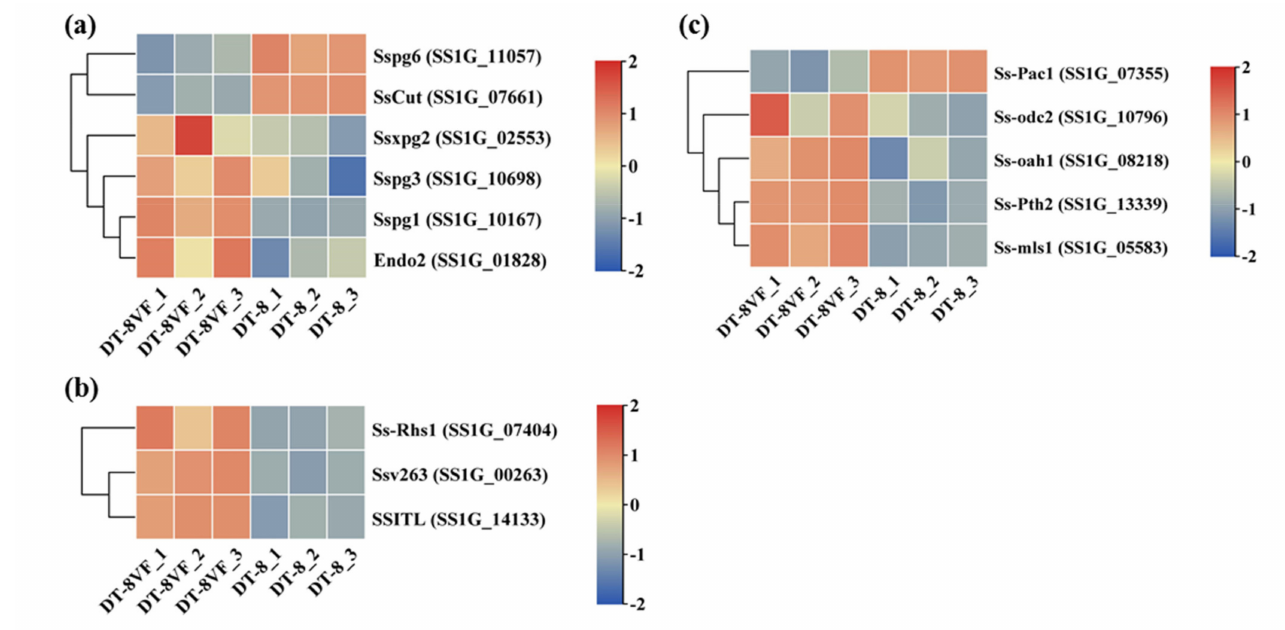
Figure 6. The expression profiles of S. sclerotiorum virulence factor genes. ( a ) The expression levels of PCWDE genes previously identified. ( b ) The expression levels of secretory protein encoding genes. ( c ) The expression levels of OA metabolism and regulation